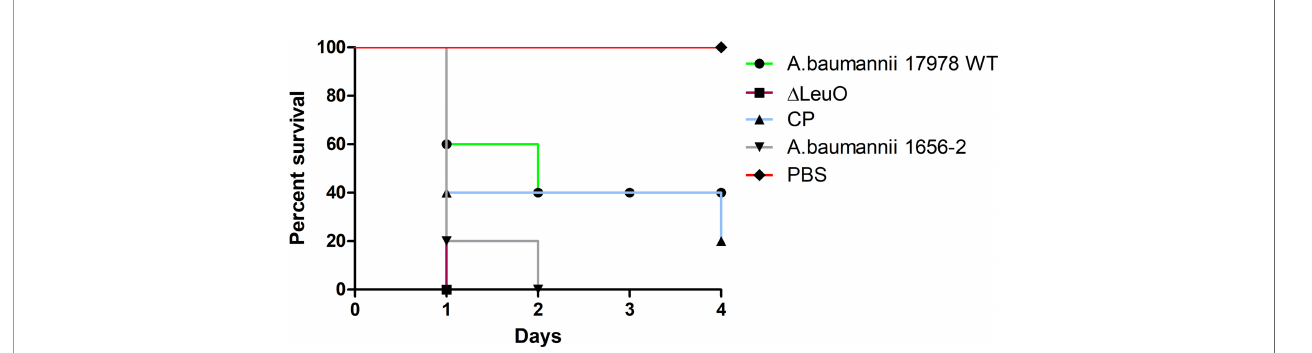
FIGURE 7 | Survival of mice infected with A. baumannii strains. Kaplan-Meier survival curves of the virulence of A. baumannii 17978 wild-type, D LeuO, CP strain and A. baumannii 1656-2 in mice were determined up to 4 days of infection. 8-week-old female BALB/c mice were injected intraperitoneally (IP) with 1 × 10 8 CFU/ml bacterial suspension of tested strains (n = 5 per group). PBS was administered as control group and survival of infected mice were monitored every 12h for 4 days. Survival curve was generated using GraphPad